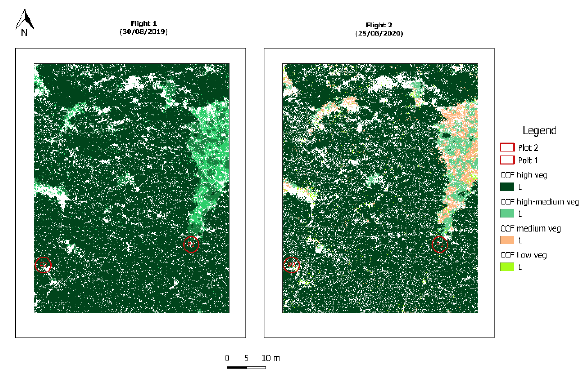
Figure 3. CCF calculated for vegetation stratum in both years of